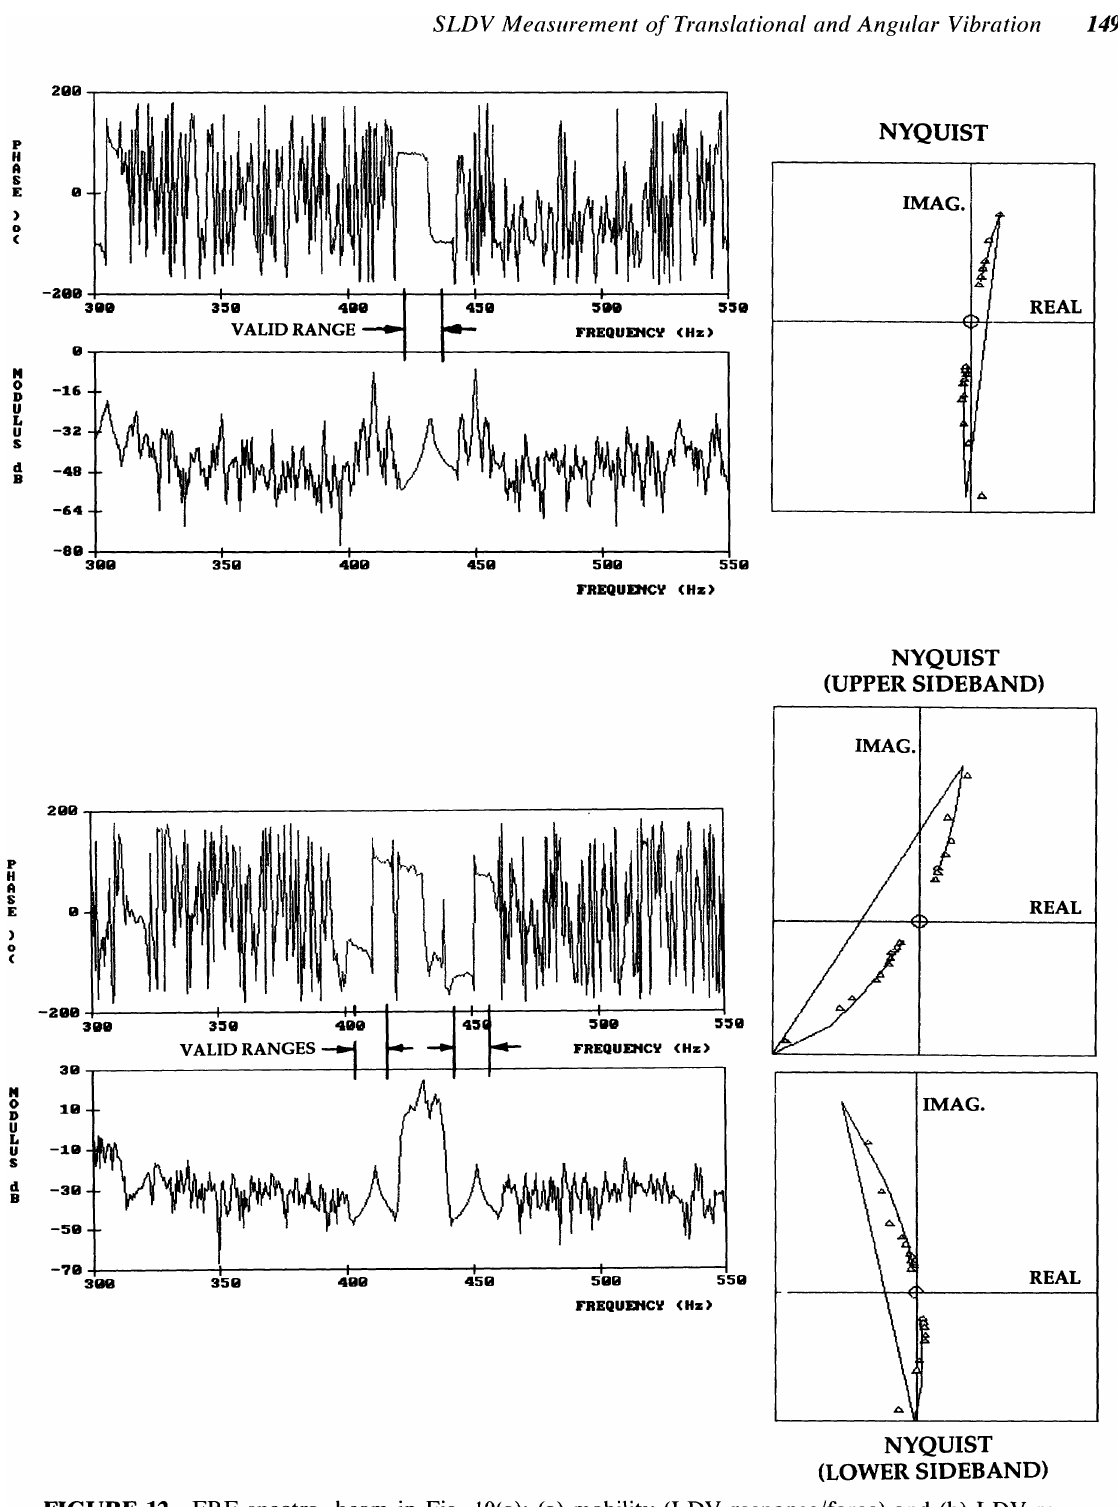
FIGURE 12 FRF spectra, beam in Fig. lO(a): (a) mobility (LDV response/force) and (b) LDV re sponse/multiplier